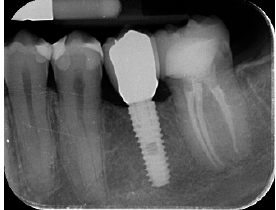
Figure 8. 18 months radiographic Figure 8. 18 months radiographic follow-up. Figure 8. 18 months radiographic follow-up. Figure 8. 18 months radiographic follow-up. Figure 8. 18 months radiographic follow-up. Figure 8. 18 months radiographic follow-up.